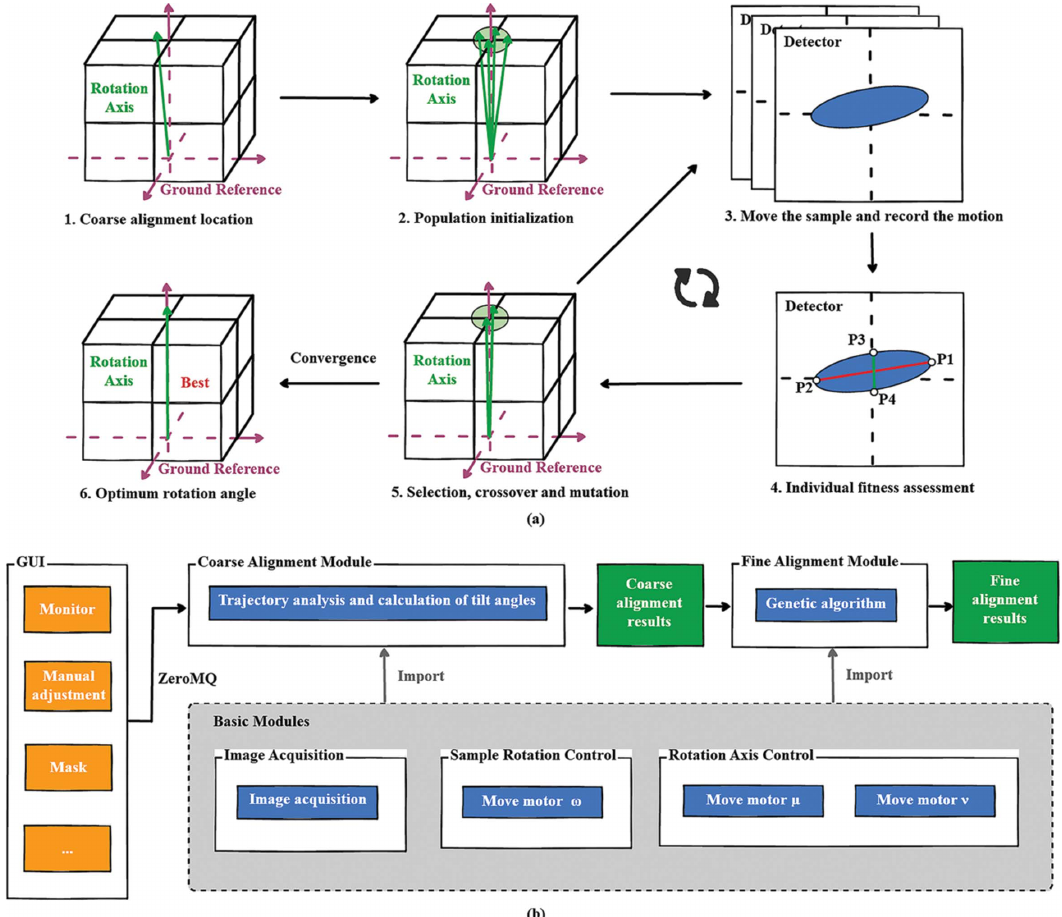
Figure 4 ( a ) The process of fine alignment of the rotation axis. Genetic-algorithm-based selection, crossover, mutation and inheritance processes for rotating-axis individuals. ( b ) Framework design of the rotation alignment software. The blue color indicates the rotation alignment algorithm and its associated functional modules, and the orange color indicates the GUI